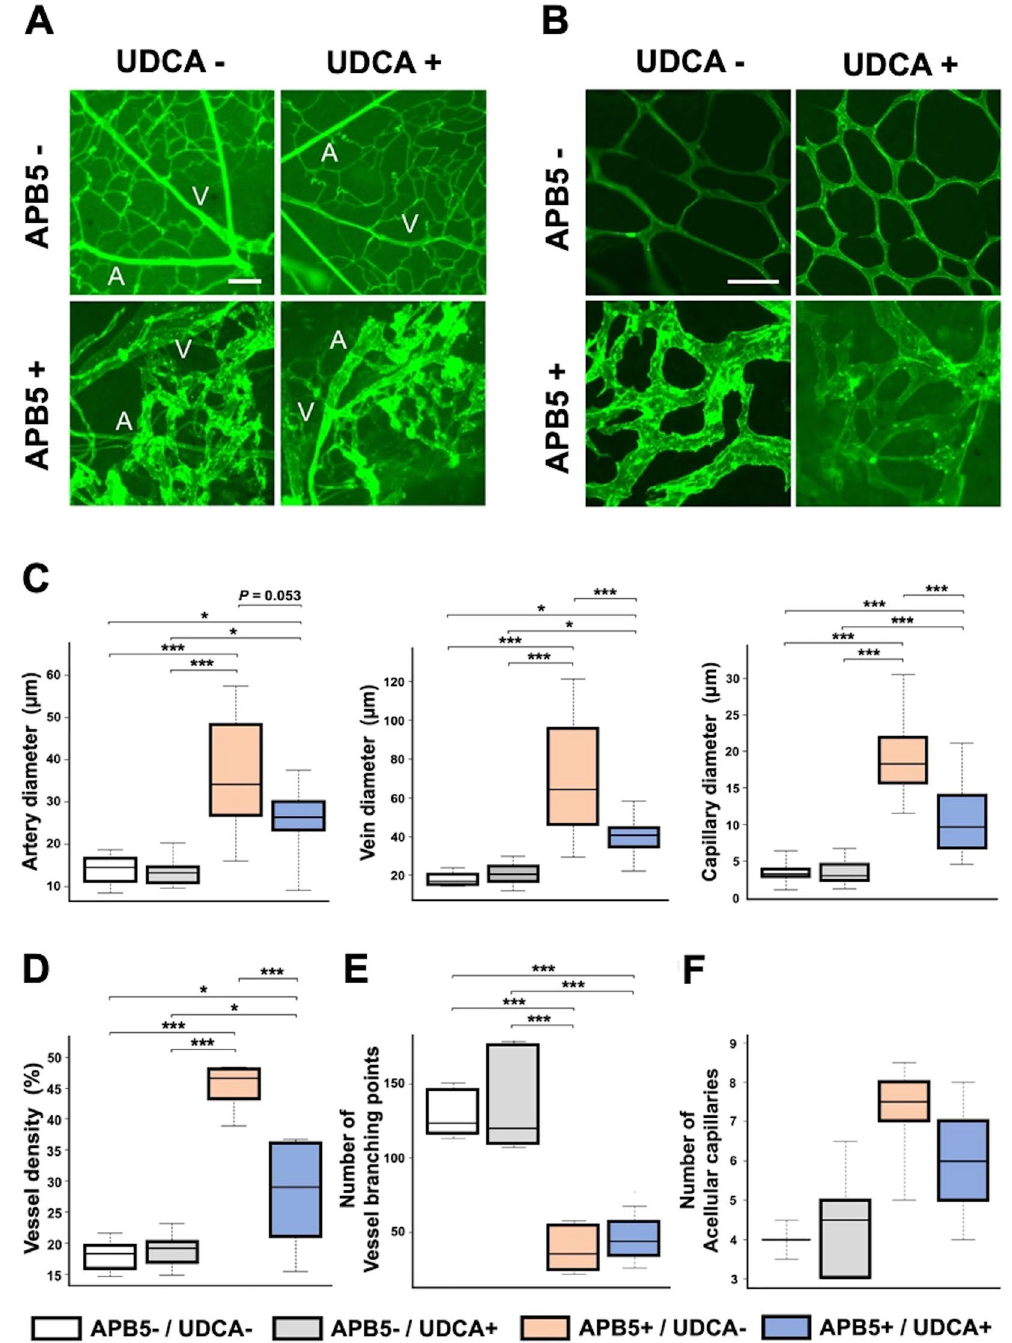
Figure 1. Ursodeoxycholic acid (UDCA) attenuates the retinal vascular abnormalities. Fluorescein-labeled concanavalin A was used for perfusion to obtain the angiographic images and to investigate the effect of UDCA on vessel morphology changes. Fundus images of the arteries and veins ( A ), capillary ( B ). A, artery; V, vein. ( C ) Quantification of vessel diameters of arteries (left), veins (middle), and capillaries (right). ( D ) The graph shows total vessel density (two 300 × 300 μ m fields per retina). ( E , F ) Number of vessel branching points and the number of acellular capillaries in a unit area of 700 × 550 μ m were measured. APB5 − /UDCA − (n = 5); APB5 − /UDCA + (n = 6); APB5 + /UDCA − (n = 6); APB5 + /UDCA + (n = 6). Data were expressed as the means ± standard error of the mean (S.E.M.). Asterisks indicate vessel lumen. * P < 0.05, ** P < 0.01, *** P < 0.001 (one-way ANOVA). Scale bars: 100 μ m ( A ); 50 μ m ( B